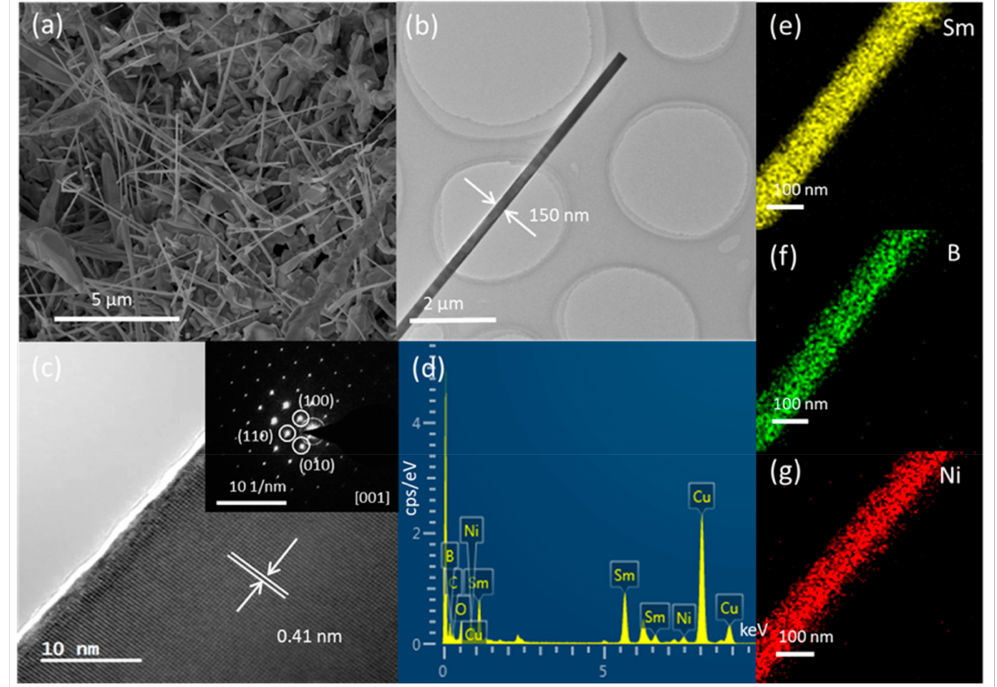
Figure 1. SmB 6 nanowires grown on Ni coated Si substrate. ( a ) SEM image; ( b ) TEM image, ( c ) HRTEM image and ( d ) EDAX spectrum of a single nanowire; element mapping of Sm ( e ), B ( f ), and Ni ( g ) of a single